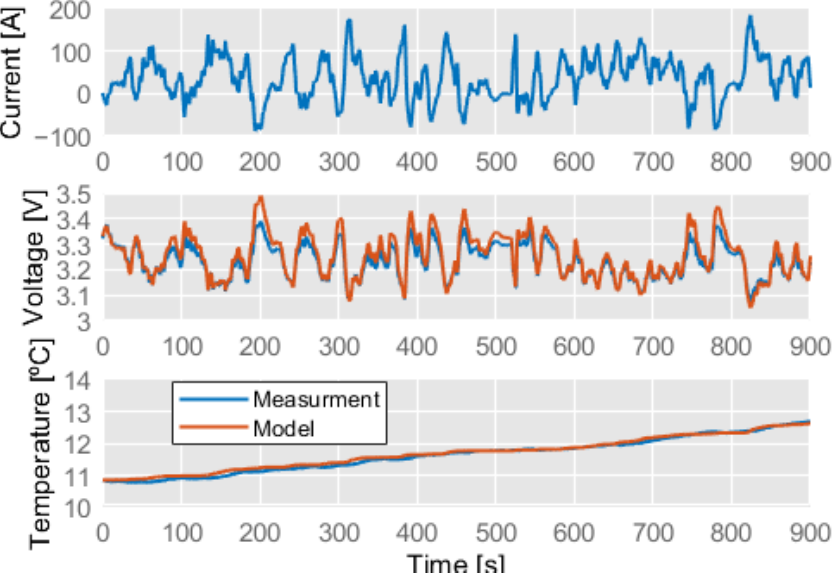
Figure 10. Electrical and thermal model validation.